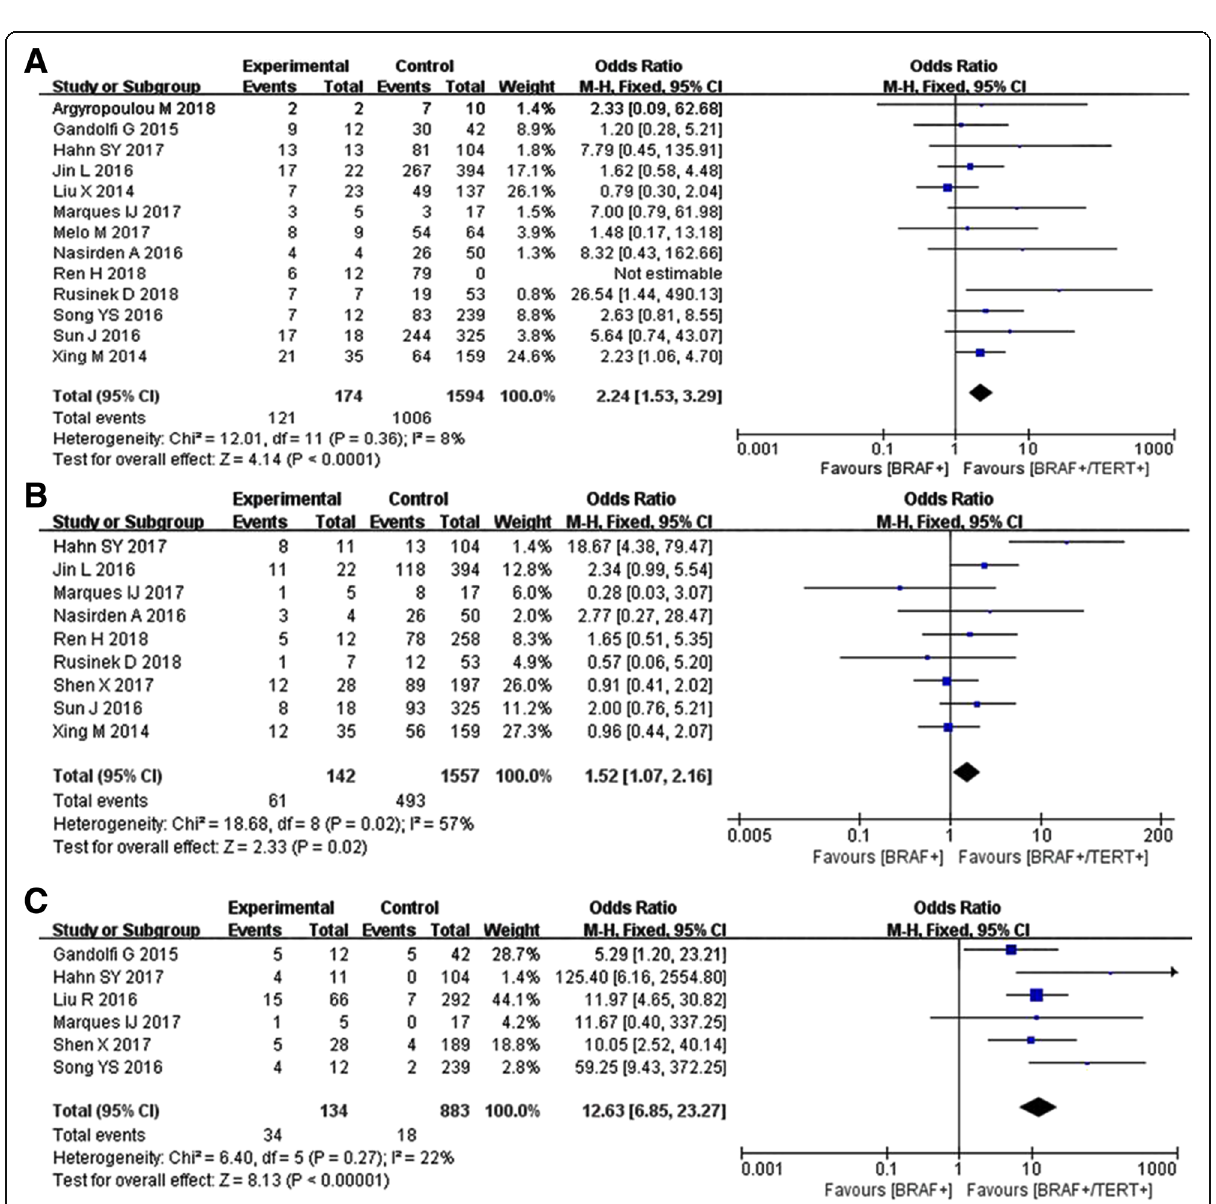
Fig. 2 Systematic analysis of the association of BRAF promoter mutation alone or BRAF/TERT coexistence with clinicopathological features in thyroid cancer. a Lymph node metastasis, b Multifocality, c Dead of